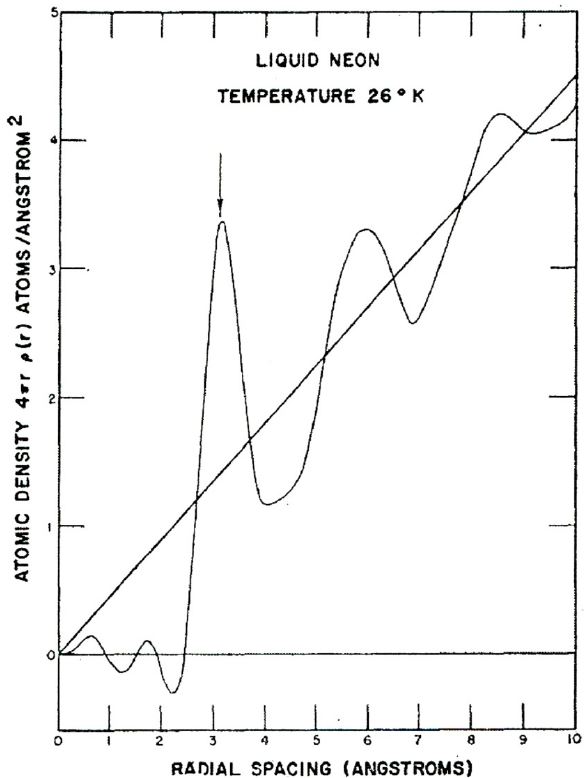
Figure 12. The atomic distribution function 4 π r ρ (r) for liquid neon at 26K. The arrow at 3.13Å represents the measured separation between two atoms in the solid at 4.2 °K. The nearest distance of approach of two atoms in the liquid is 2.45Å, while the number of neighbors around each atom is about 8.8. The oscillations below 2 Å are spurious and have their origin in the limited wavevector range, Q, of the experiments. This figure is taken from Figure 5 of ref. [45]. Copyright by the American Physical Society.